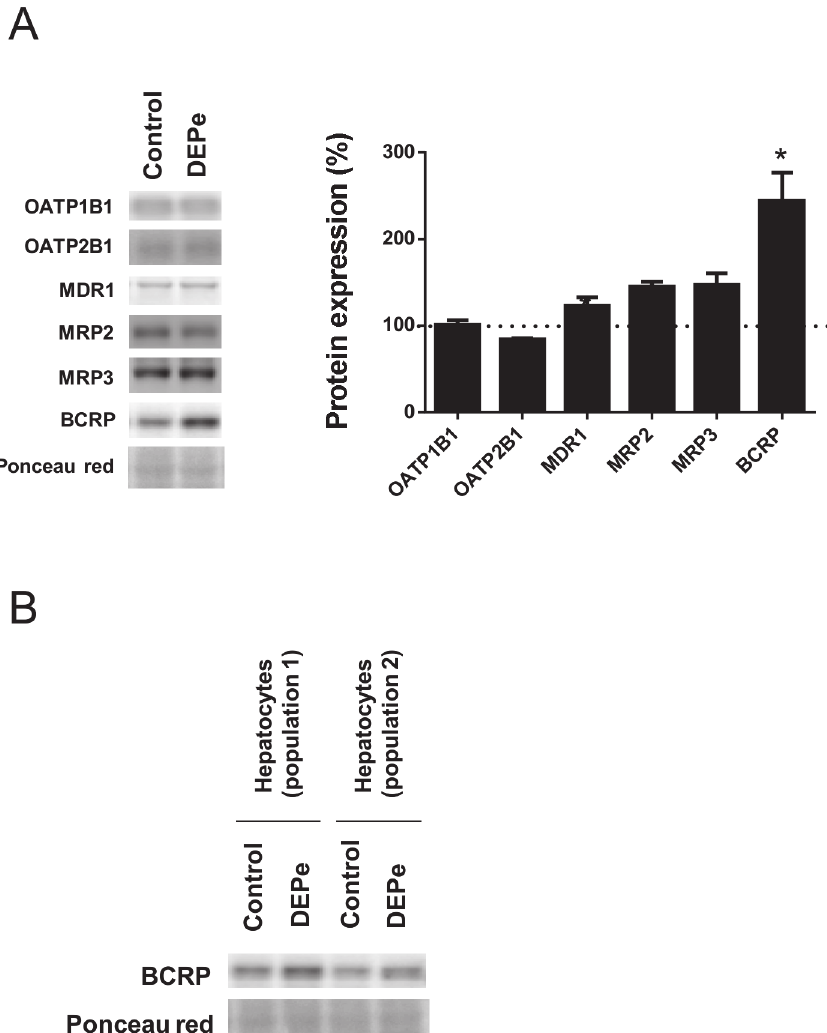
Fig 6. Regulation of drug transporter protein expression by DEPe. (A) HepaRG cells were either untreated (control) or exposed to 25 μ g/mL DEPe for 48 h. Transporter protein content was then determined by Western-blot analysis. Left panel, a representative blot is shown for each transporter. Right panel, for each transporter, data were quantified by densitometric analysis, normalised to Ponceau red staining and expressed relative to transporter expression found in untreated cells, arbitrarily set at the value of 100% and indicated by a dotted line; they are the means ± SEM of values from four independent assays. * , p < 0.05 when compared to untreated cells (ANOVA followed by a Dunnett ’ s post-hoc test). (B) Two independent populations of primary human hepatocytes were either untreated (control) or exposed to 25 μ g/mL DEPe for 48 h. BCRP protein content was then determined by Western-blot